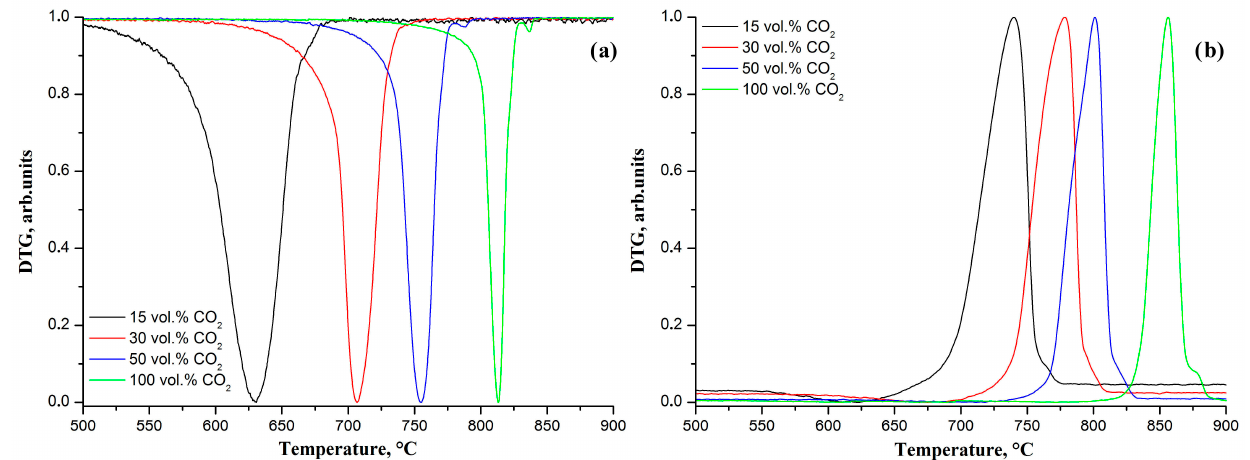
Figure 1. Normalized DTG signals ( a ) during the sorbent carbonation at different CO 2 concentrations in the gas flow; ( b ) during the sorbent decarbonation if different CO 2 concentrations are used at the carbonation stage. Table 1. The carbonation and decarbonation rates peaks characteristics. CO 2 Concentrations in the Gas Flow during Carbonation,